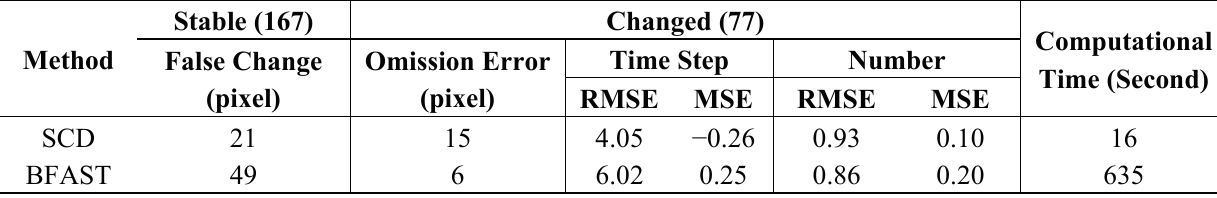
Table 4. Summary of the results for the random samples in the